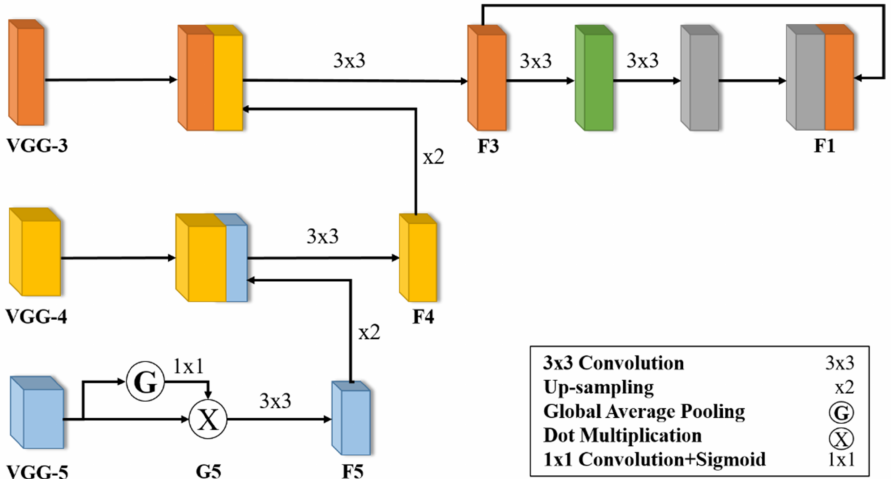
Figure 3. Detailed illustration of our global information perception module (GIPM). It contains a structure similar to U-Net to pass global information step by step and uses a short-cut at the tail to refine the outputs.